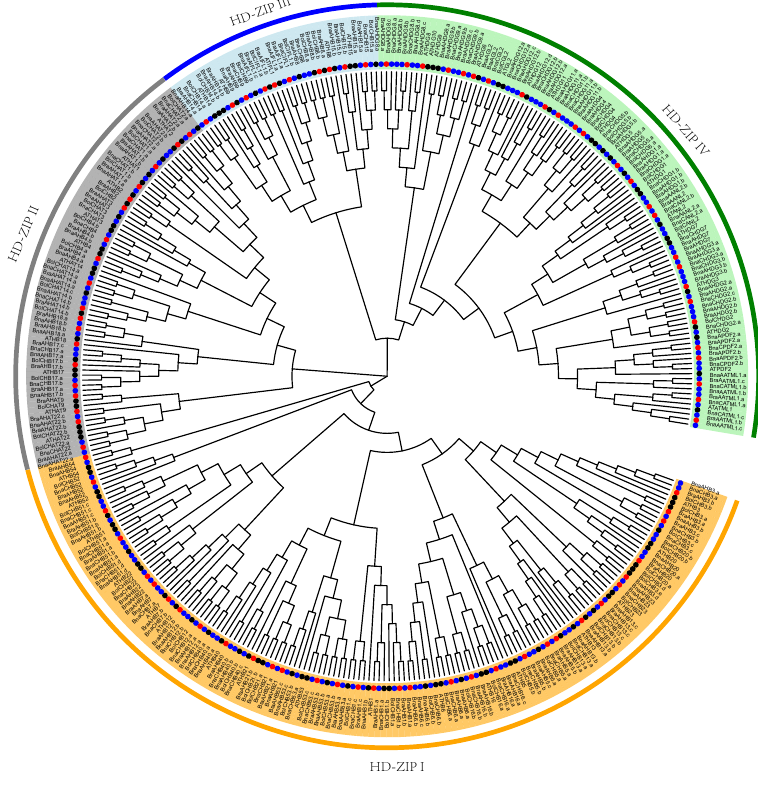
Figure 1. Phylogenetic analysis of HD-Zip proteins from B. napus , A. thiliana , B. rapa , and B. oleracea . This NJ phylogenetic unrooted tree was constructed using MEGA 7.0 and was divided into four subfamilies. Bootstrap replicates = 1000. The four species are represented with different circles in red ( B. napus ), blue ( B. rapa ), green ( B. oleracea ), and black ( A. thiliana ). There were 129 closely related sister pairs at the end of the branch of the phylogenetic tree, of which 63 were direct homologous pairs of the Ar–An genomes and 39 were Co–Cn